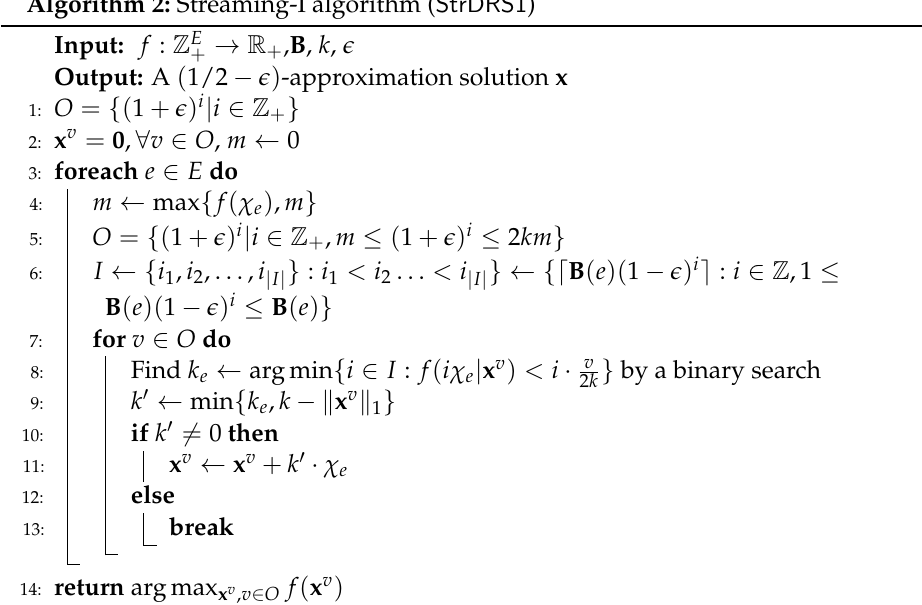
Algorithm 2: Streaming-I algorithm ( StrDRS1